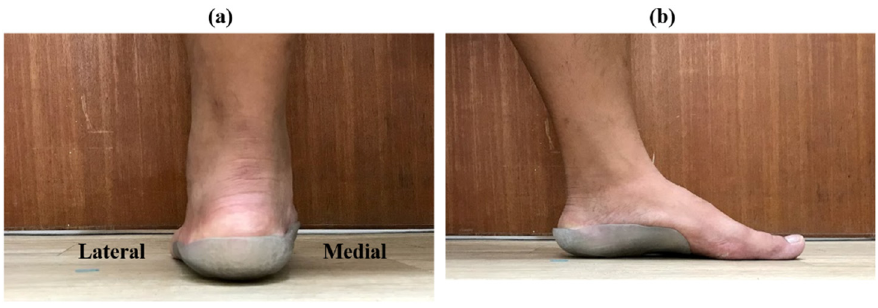
Figure 3. ( a ) Rear view and ( b ) medial view of the foot orthosis.